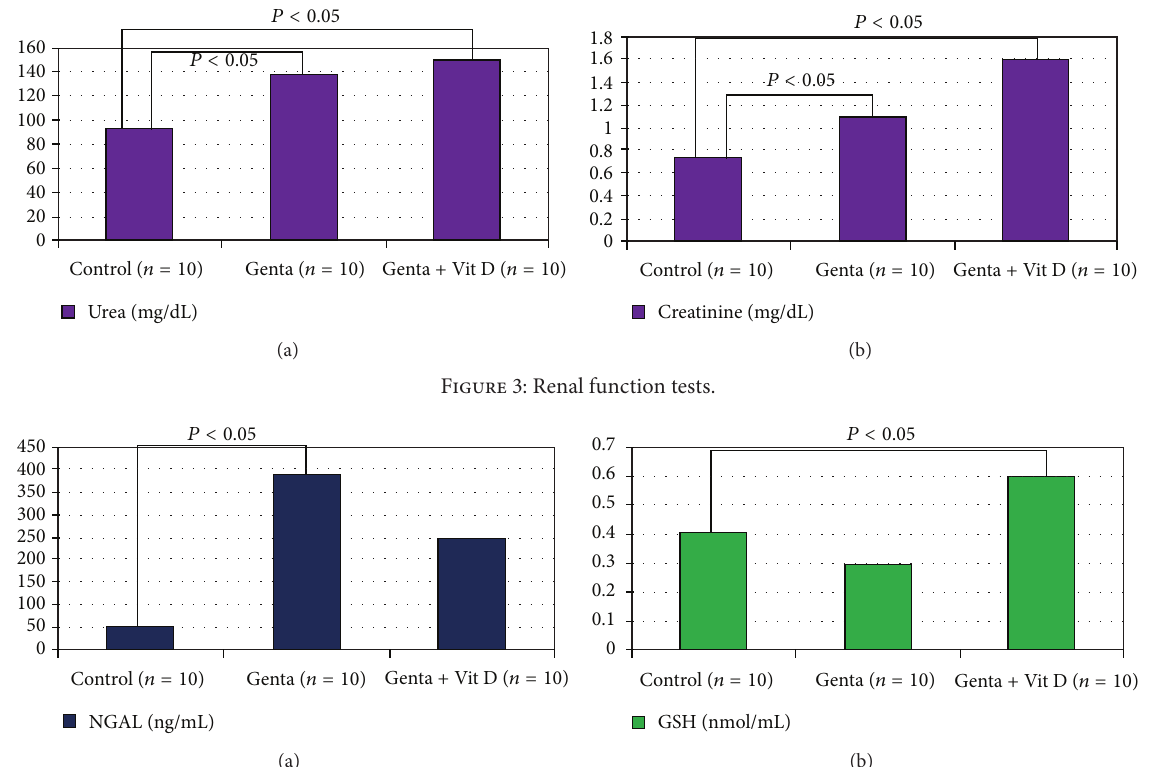
Figure 4: Urine neutrophil gelatinase-associated lipocalin and glutathione levels.